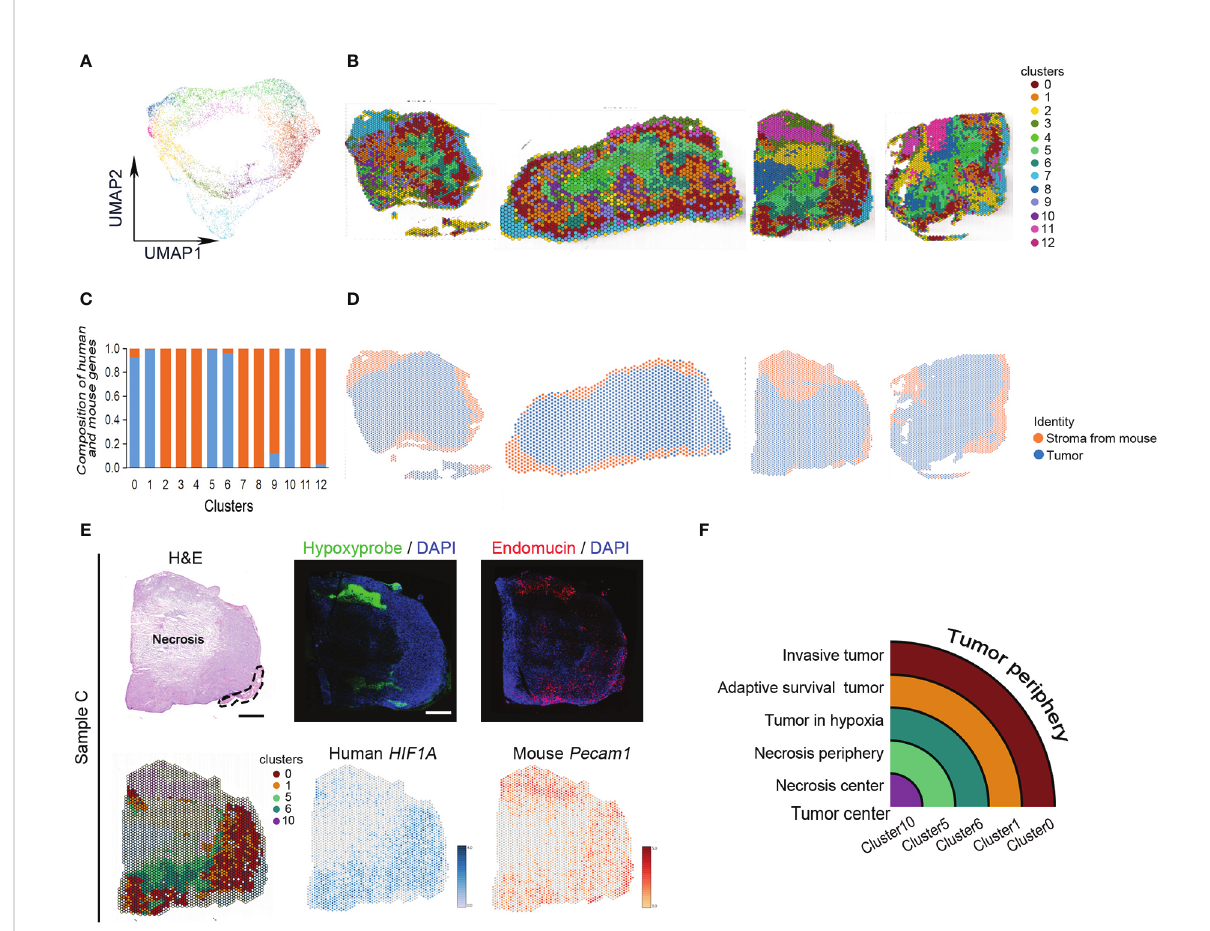
FIGURE 2 Classi fi cation of MDA-MB-231 engrafts. (A) UMAP clustering graph for four samples. (B) Spatial distribution of all clusters in four samples. (C) Composition of human- and mouse-derived differentially expressed genes. (D) Spatial distribution of human- and mouse-derived spots in four samples. (E) Hematoxylin and eosin (H, E) staining of tissue sections and clustering of ST spots of sample (C) The dashed line indicates skeletal muscle. Scale bar, 1 mm. Immuno fl uorescence staining for hypoxyprobe and endomucin of sample (C) Spatial feature plots of human HIF1A and mouse Pecam1 expression in tissue sections. (F) Ideograph of comparison of hypoxia-dependent ST cluster and tumor tissue region